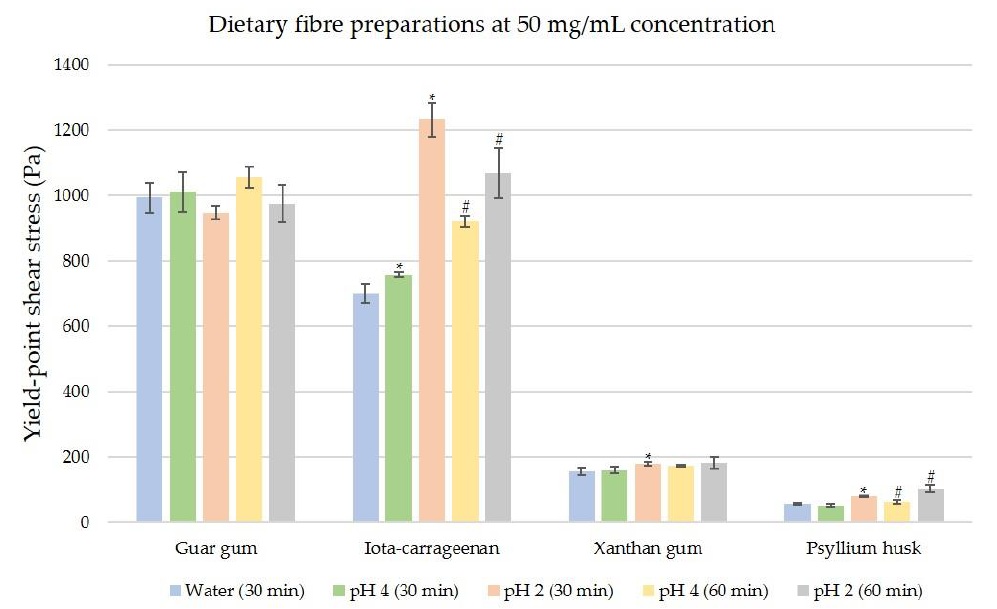
Figure 4. Comparisons of yield-point shear stresses of four ‘high-viscosity’ fibres; guar gum, iota-carrageenan, xanthan gum, and psyllium husk at concentration of 50 mg/mL. Test conditions are in distilled water (pH 7), and simulated digestion at pH 4 and pH 2. The data tip (*) indicates significant difference between the distilled water condition and the simulated digestion condition (pH 4 or pH 2) at 30 min. The data tip (#) indicates significant difference between the simulated digestion condition at 30 min (pH 4 or pH 2) and its corresponding simulated digestion condition at 60 min. The significance level is p ≤ 0.05 for both (*) and (#).